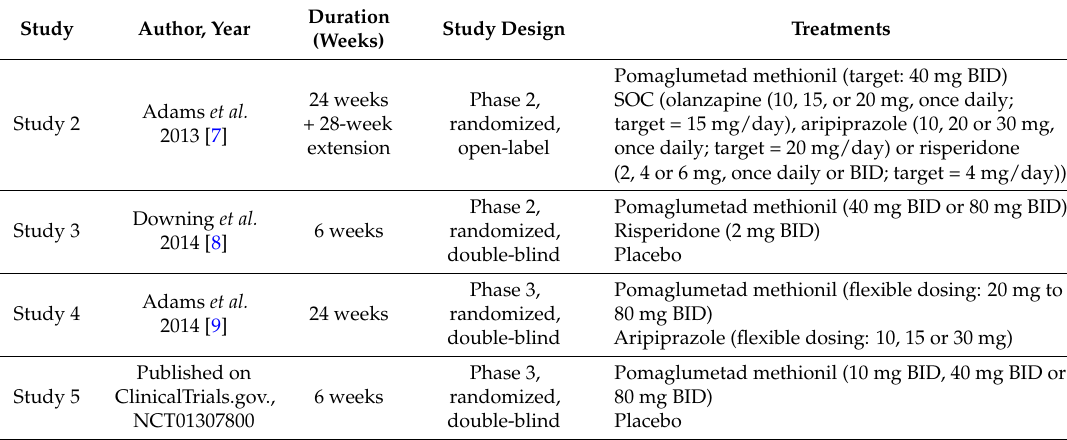
Table 1. Study characteristics. SOC,